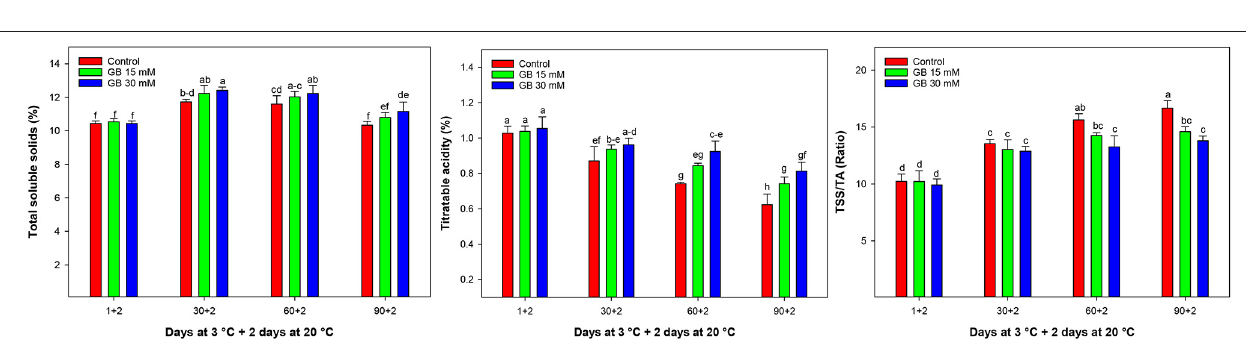
FIGURE 2 | Changes in total soluble solids (TSS), titratable acidity (TA), and TSS/TA in control and GB-treated fruit of “Moro” blood orange at 3 ◦ C. Different letters and vertical bars show a significant difference ( p < 0.05) and standard errors ( ± SE) of means, respectively.